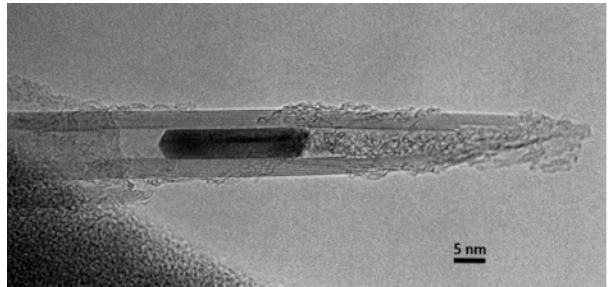
Figure 6. Nanotube partially filled with metallic nickel prepared by hydrogen reduction of a NiO precursor. Reproduced with permission from [57]. Springer Nature, 1994.